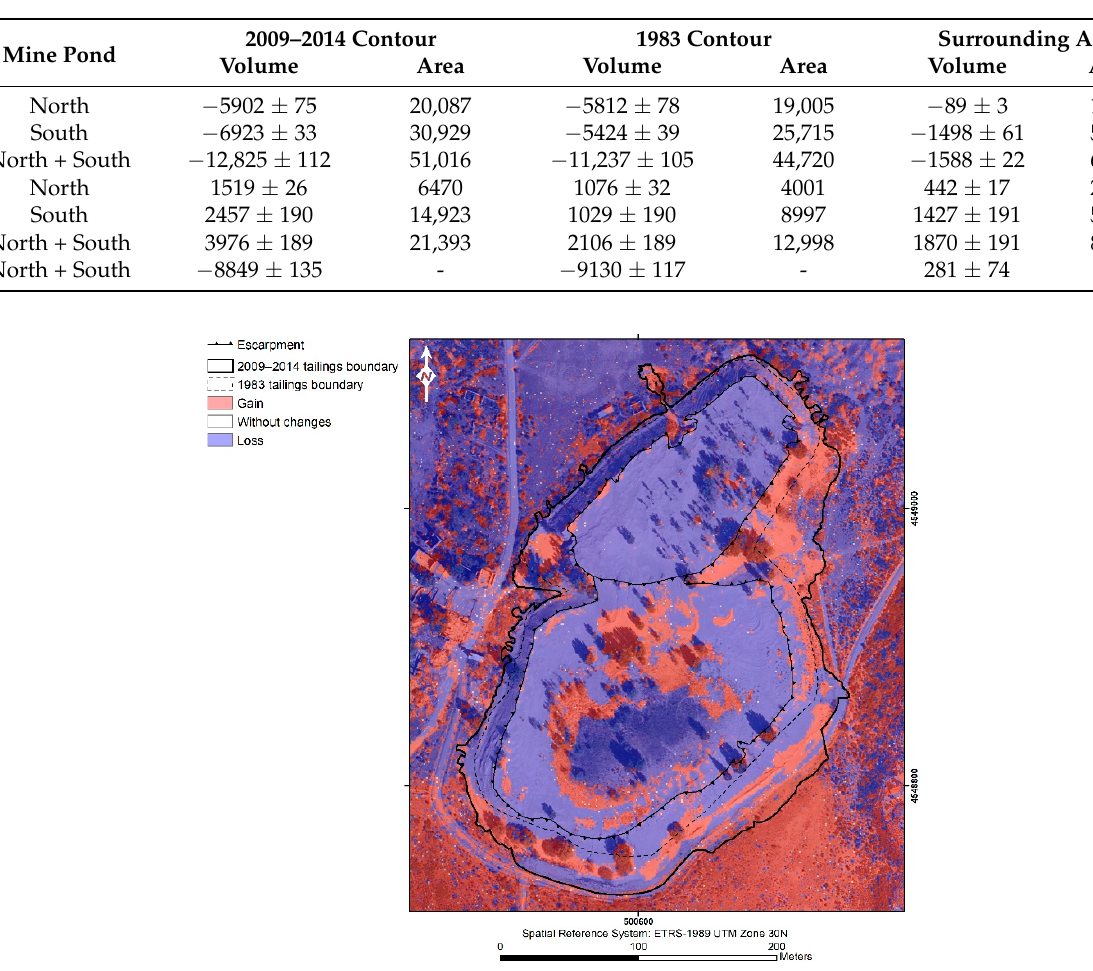
Table 4. Sludge loss and gain between 2009 and 2014 expressed in volume (m 3 ) and area (m 2 ), with the breakdown of values inside (1983 contour) and outside (surrounding area) the 1983 boundary of the ponds.